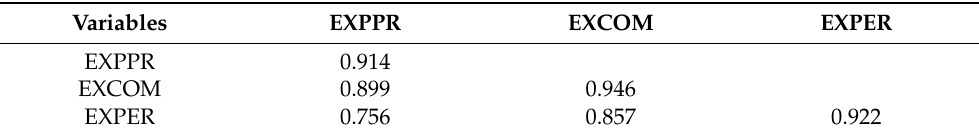
Table 2. Discriminant